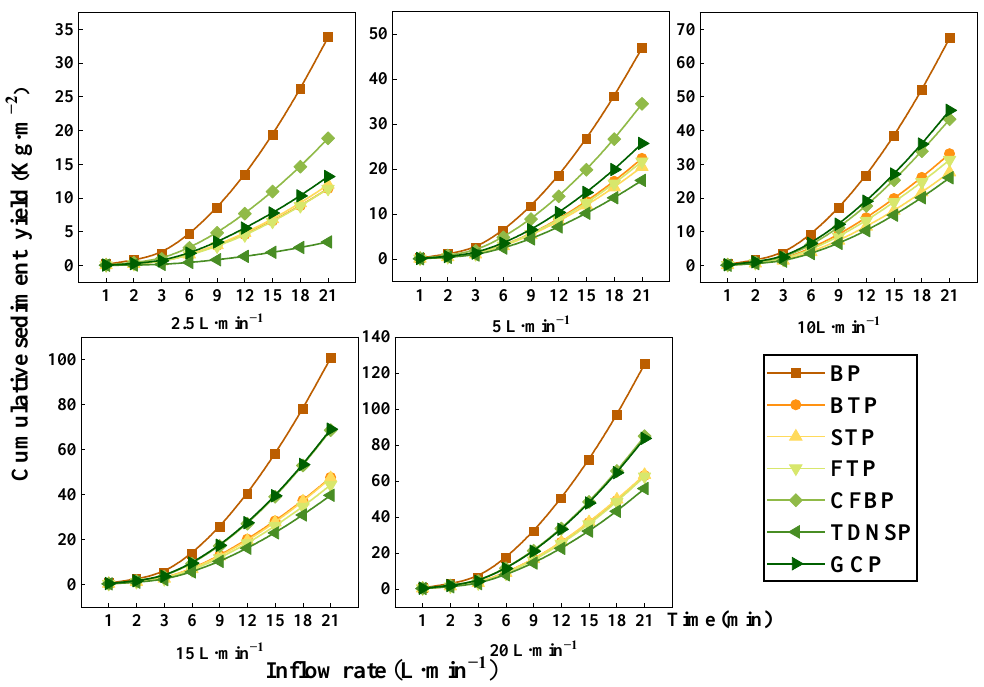
Figure 9. Soil loss of seven measures under different inflow times.